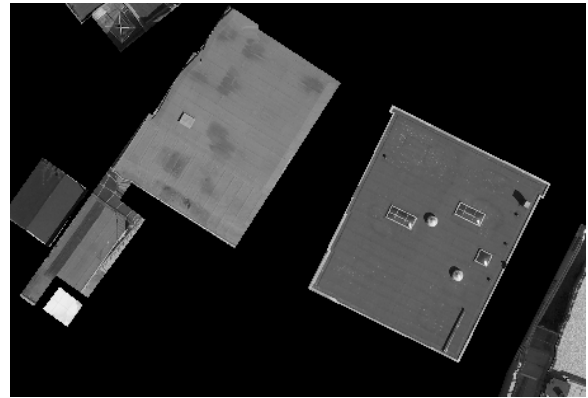
Figure 5: Roofs (detail) 2010